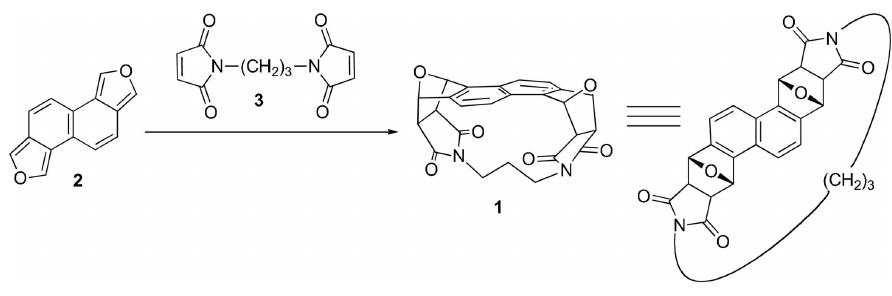
The formation of the title